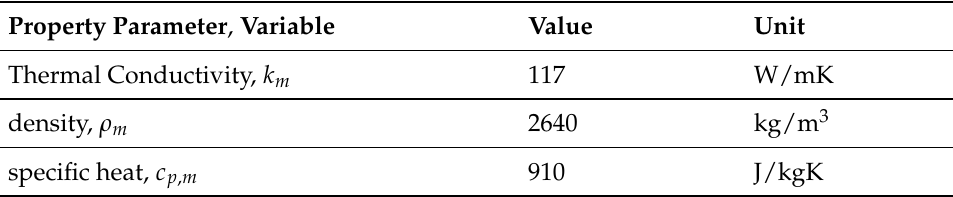
Table 3. Metal Mesh Properties: Aluminum